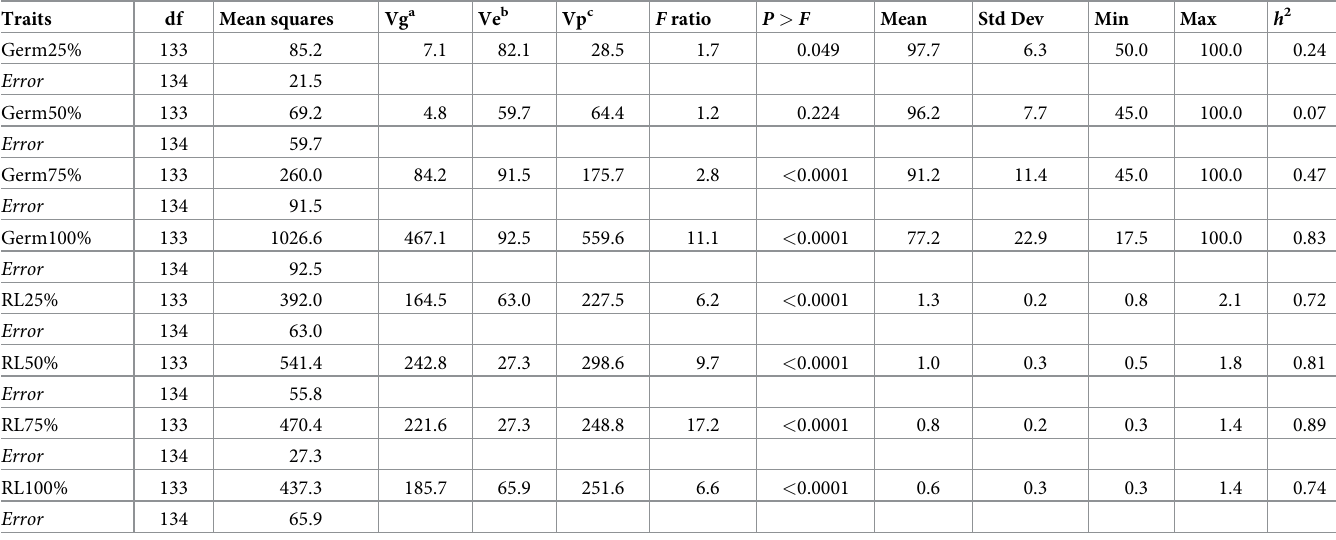
Table 2. Analysis of variance (ANOVA), distribution, heritabilty ( h 2 ) and genetic advance (R) of seven yield and yield components studied in 134 F 2:3 lines. Traits df Mean